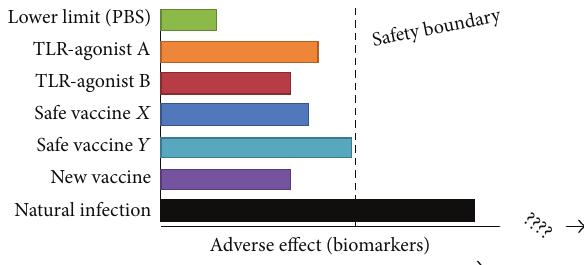
Figure 6: Illustration of need to identify a “safety boundary” on the sliding scale of adverse effects or biomarkers observed in response to “known to be safe” vaccines, immune agonists, and natural infection in animal models and human experimental